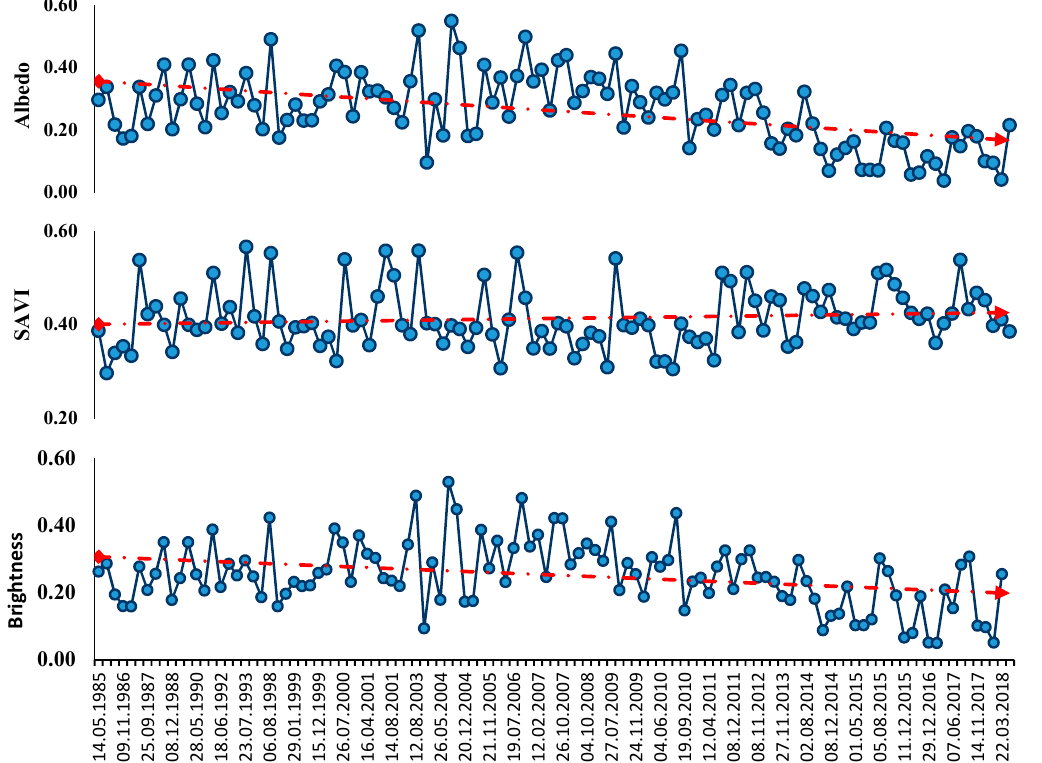
Figure 7. The mean normalized values of each surface biophysical parameter.